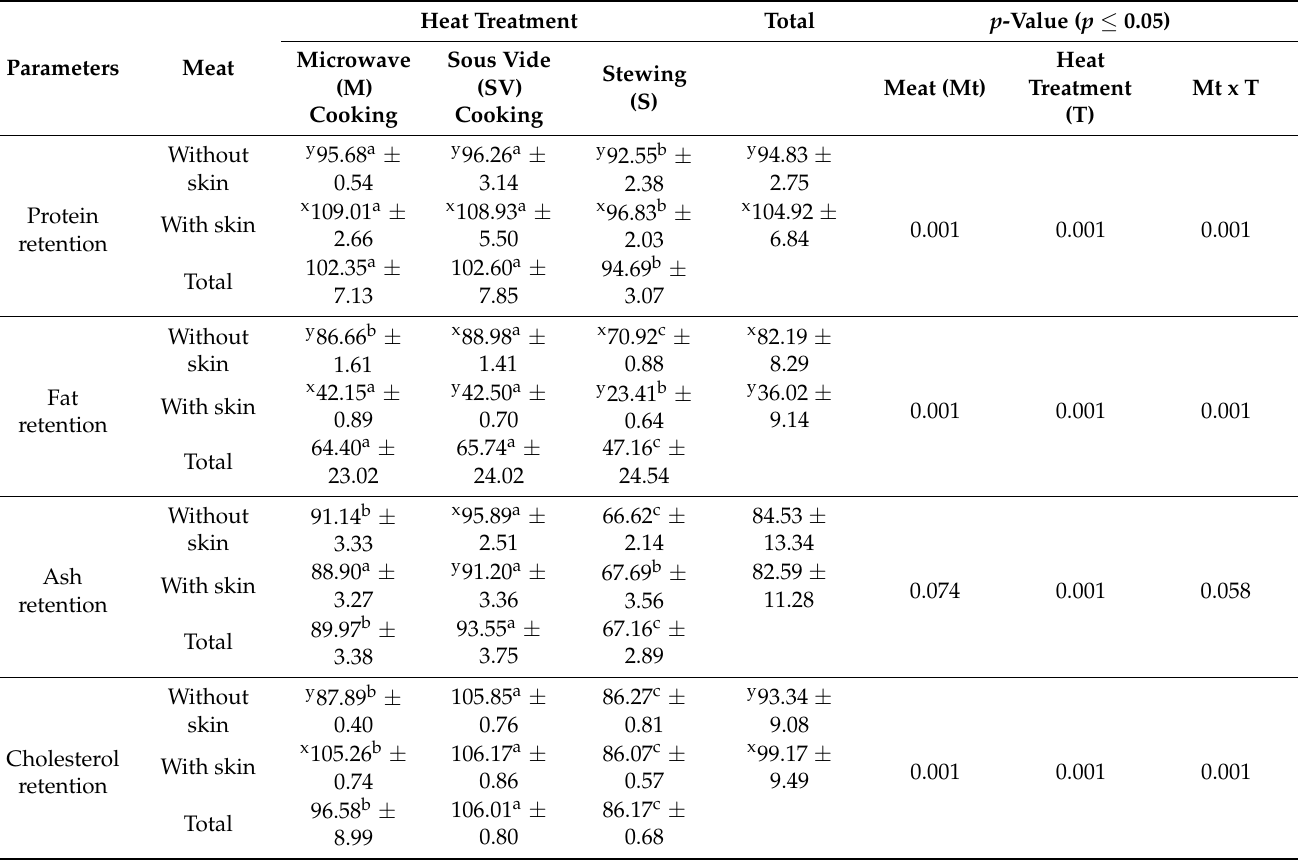
Table 3. Nutrient retention coefficients (%) in raw and cooked goose meat (n = 6 breast muscles with skin and n = 6 without skin for each kind of heat